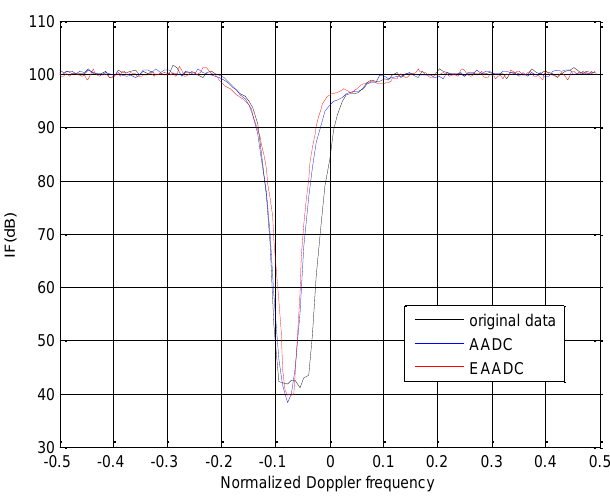
Figure 7. IF of 3DT after the application of the compensation techniques.